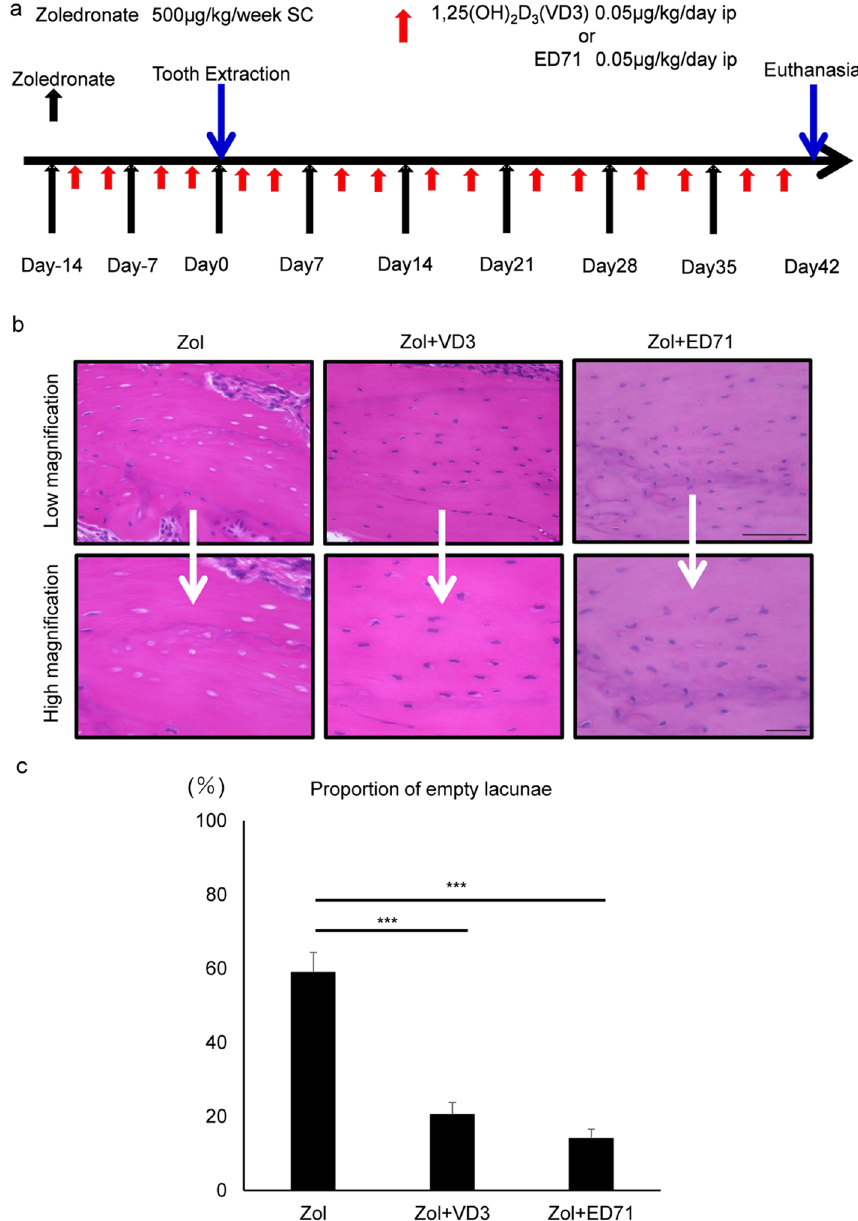
Figure 1. ED71 or VD3 treatment significantly blocks osteonecrosis development in mice treated with zoledronate. ( a ) Experimental protocol. In all experiments, 8-week-old female C57BL/6 mice received subcutaneous injection of zoledronate (500 μg/kg) once a week. Vehicle (ethanol: 0.05 µl/kg/day), ED71 or 1,25(OH) 2 D 3 (VD3) (0.05 µg/kg/day) was intraperitoneally injected twice a week for 2 weeks before extraction and afterwards twice a week. ( b ) Two weeks after the first injection when mice were 10 weeks old, the right first and second molars in mandible were extracted. Six weeks after extraction, mandibles were removed, stained with HE, observed microscopically, and the percent of empty lacunae among all lacunae was evaluated. Scale bars = 100 μm (upper) and 20 μm (lower) panels. ( c ) Data represents mean relative proportion of empty lacunae among all lacunae in bone ± SD (each with n = 5, ***P < 0.001). Representative data are shown of at least two independent and identical experiments, each with n =